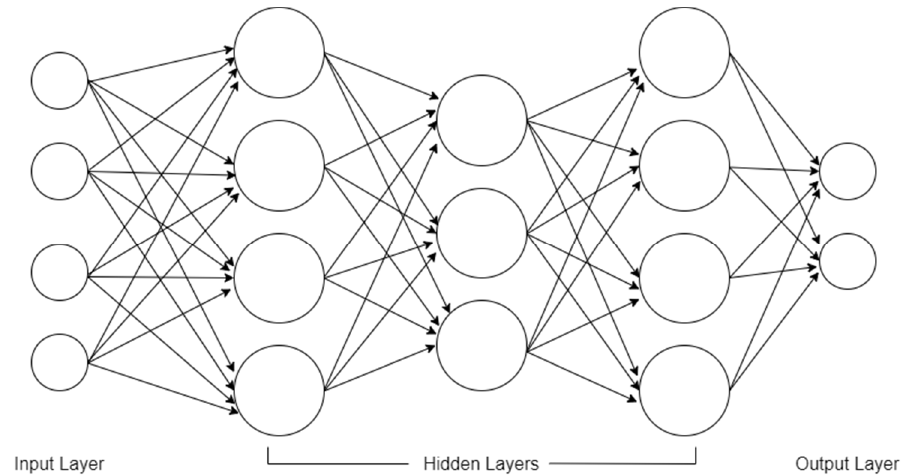
Figure 5. A sample topology of multilayer perceptron with 4 inputs, 3 hidden layers with size of 4, 3, and 4 neurons, respectively, and 2 neurons as the output layer [37].